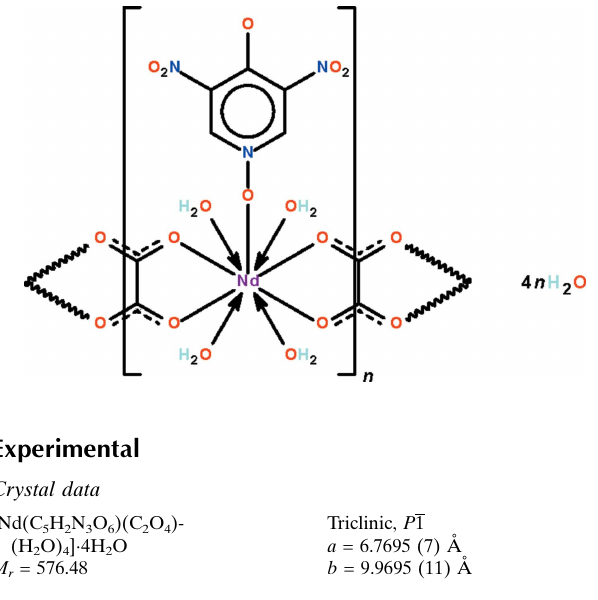
For a related Nd(III) structure, see: Wang et al. (2010).